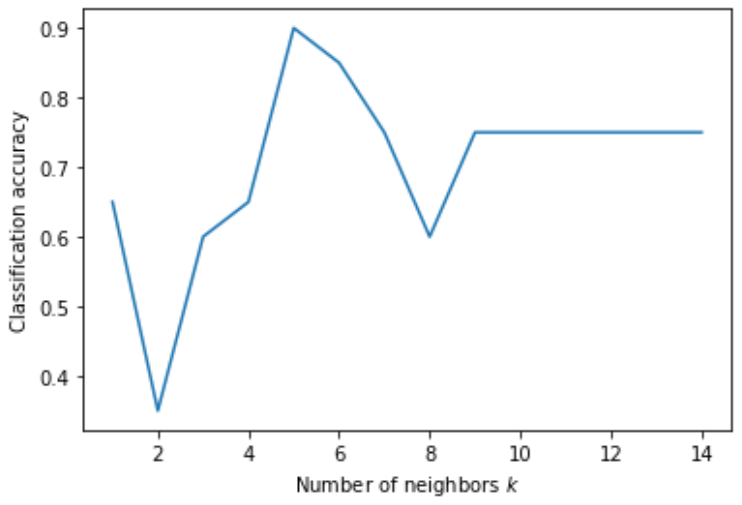
Figure 6. Classification accuracy according to k parameter of KNN on Dataset 05.